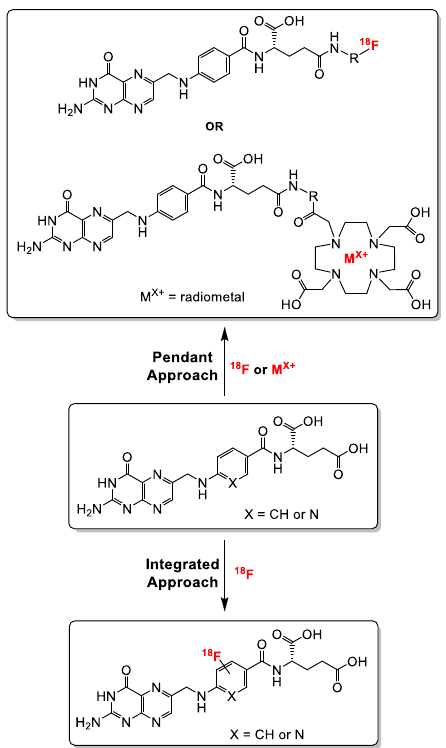
Figure 3. General synthetic strategies towards the synthesis of radiolabeled folates using the pendant and the integrated approaches. The radiolabeling of folates with radiometals is only possible via the pendant approach (DOTA chelator is shown as a representative example).